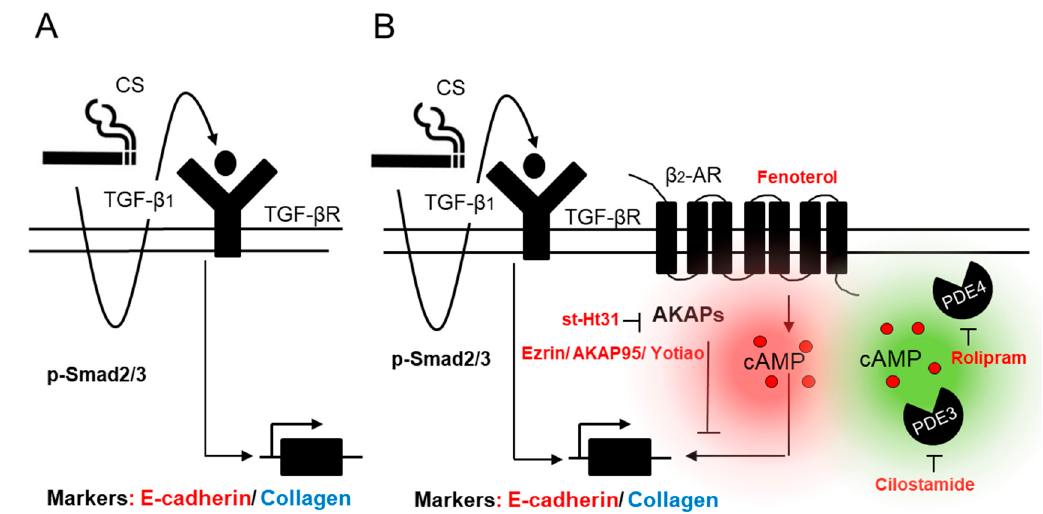
Figure 13. Proposed molecular mechanism explaining the role of different cAMP compartments in TGF- β 1/CS-induced EMT in human bronchial epithelial cells. CS exposure induces TGF- β 1 release, which in turn activates EMT via SMAD-dependent pathway ( A ). AKAPs, especially focusing on TGF- β 1 sensitive AKAPs, Ezrin, AKAP95, and Yotiao, are involved in TGF- β 1-induced collagen Ӏ upregulation. Elevation of cAMP by fenoterol, rolipram, and cilostamide differentially diminish TGF- β 1-induced EMT. Ezrin, AKAP95, and Yotiao seem to be associated with the β 2 -AR but not PDE3 or PDE4 to regulate the suppression of TGF- β 1-induced collagen Ӏ upregulation ( B ).